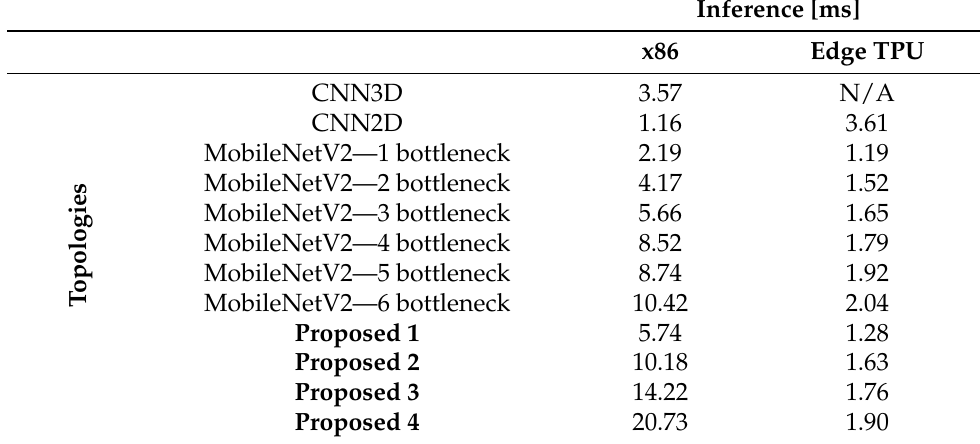
Table 4. Inference